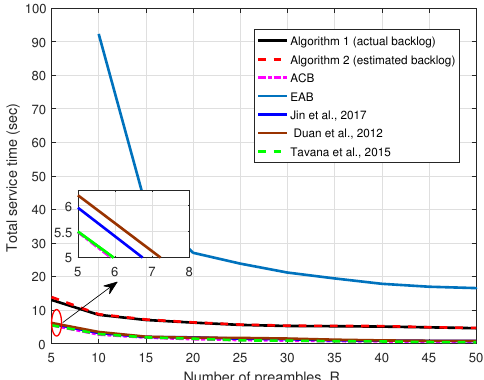
Figure 4. Total service time (TST) vs. number of preambles, R .